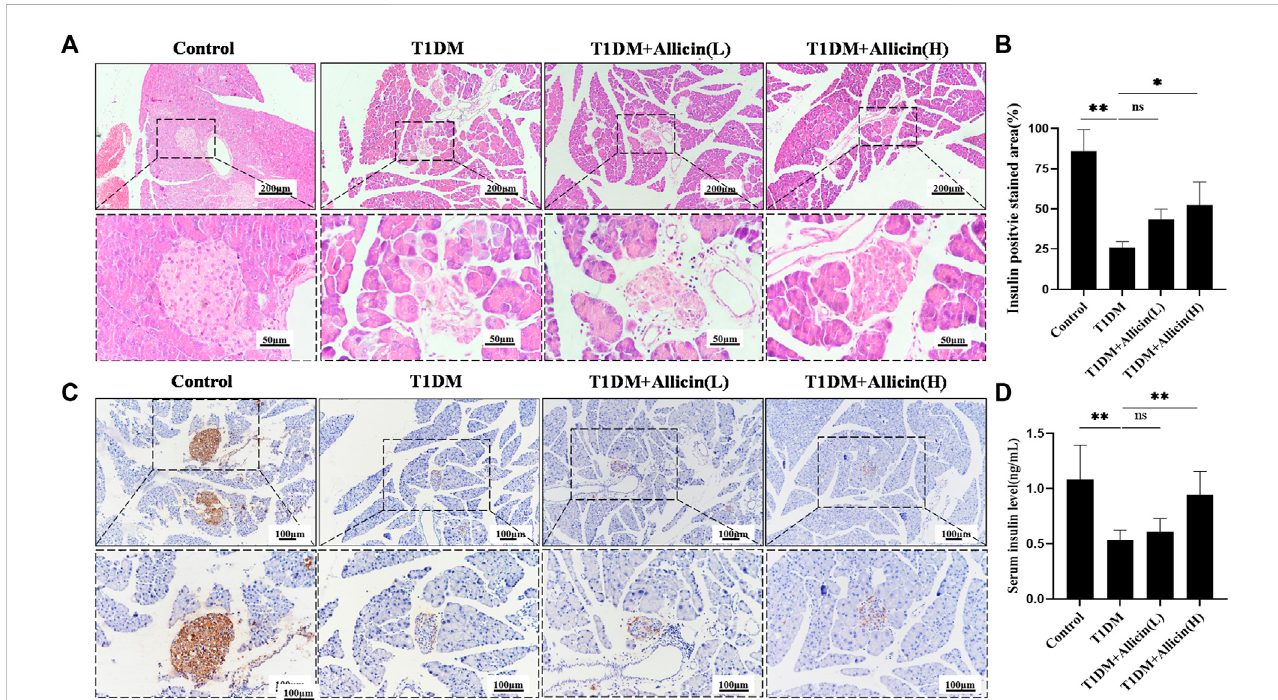
FIGURE 2 Allicin attenuated the islet structure and function in T1DM mice. (A) Hematoxylin-Eosin (HE) staining of pancreatic sections in each group. (B) The immumohistochemical staining of insulin in each group. (C) The quantitative analysis of immumohistochemical staining ( n = 3). (D) ELISA analysis of serum fasting insulin levels ( n = 3). Mean ± SD. *p < .05, **p < .01, ***p < .001 indicate signi fi cant differences, and ns > .05 shows no difference. Scale bars 200, 100, and 50 μ